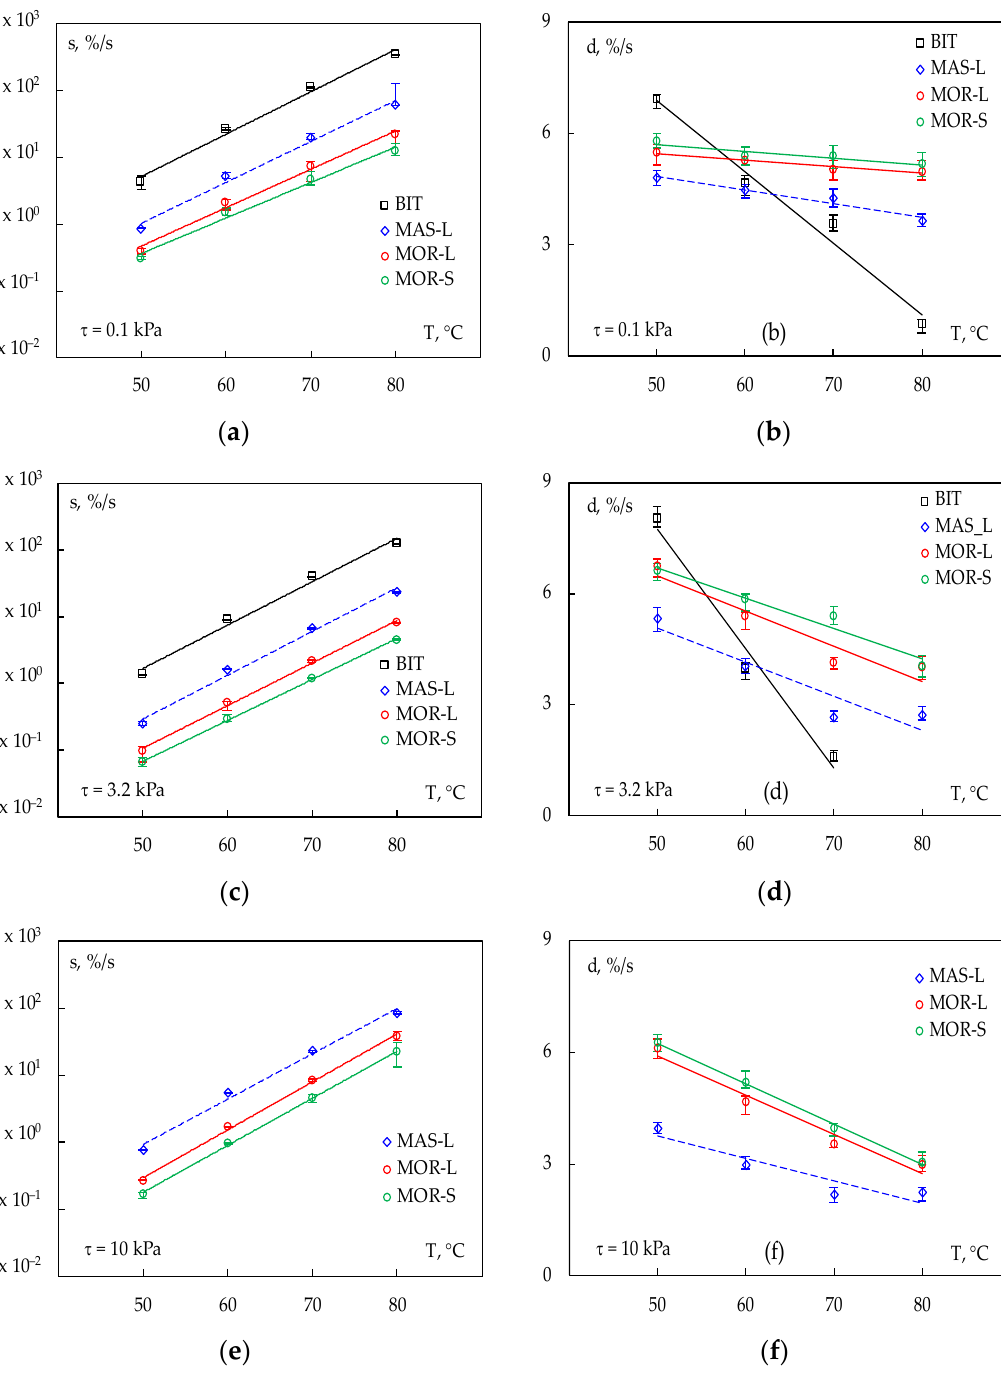
Table 6. Physical parameters describing creep-recovery strain evolution.